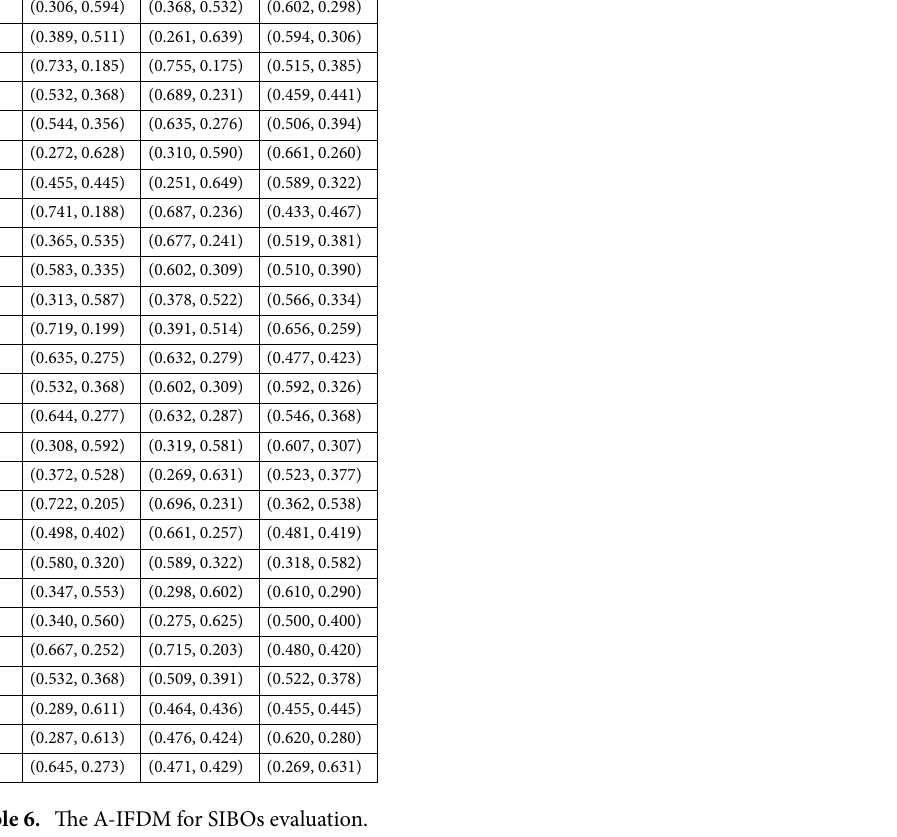
˜ ς ij of SIBOs are presented in Table 13. Corresponding to (cid:31) (cid:30)